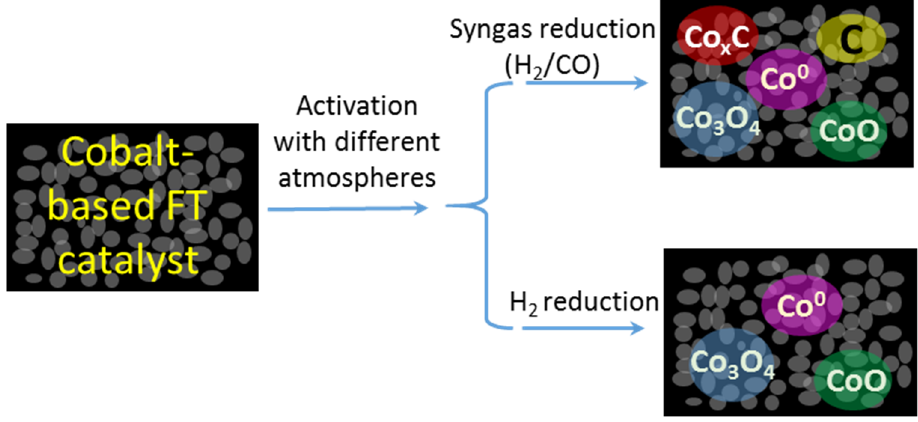
Figure 11. Cobalt phases during pretreatment of the cobalt-based FT catalyst.